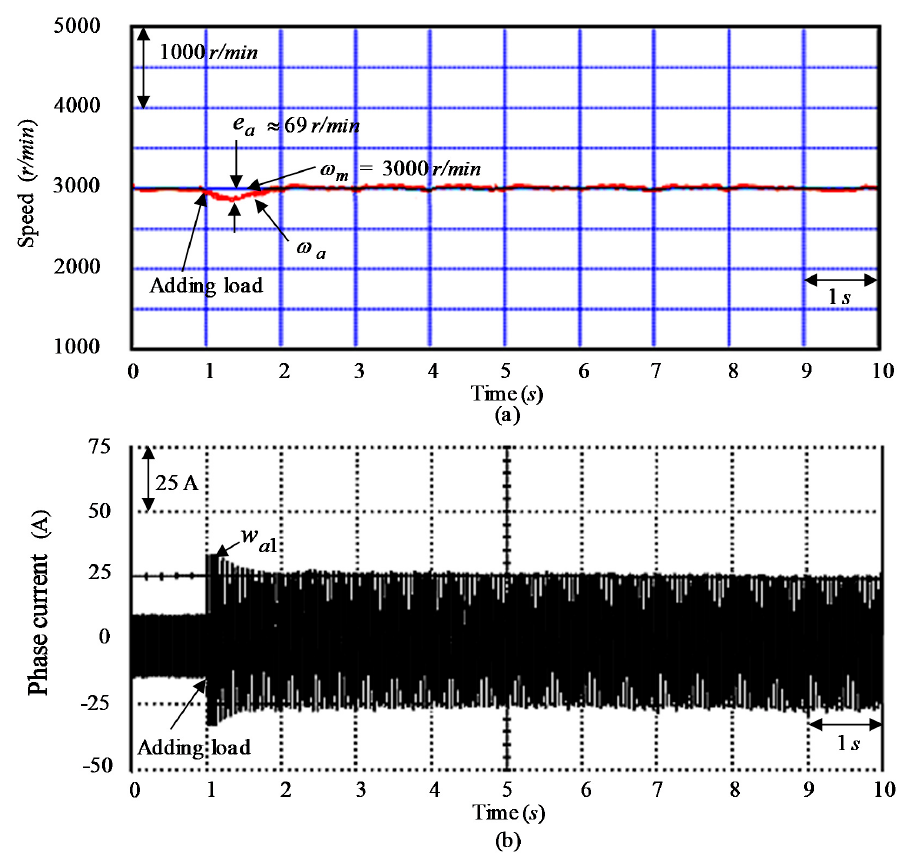
Figure 19. Tested results at the tested Event E3 case by using the controller CT3: ( a ) speed-adjusted response; ( b ) current response in phase a.